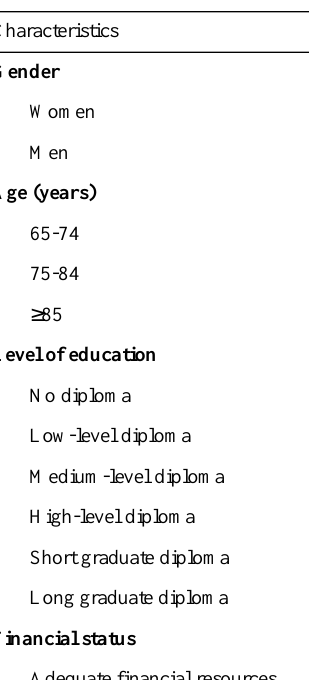
Table 1. Participants’demographic characteristics